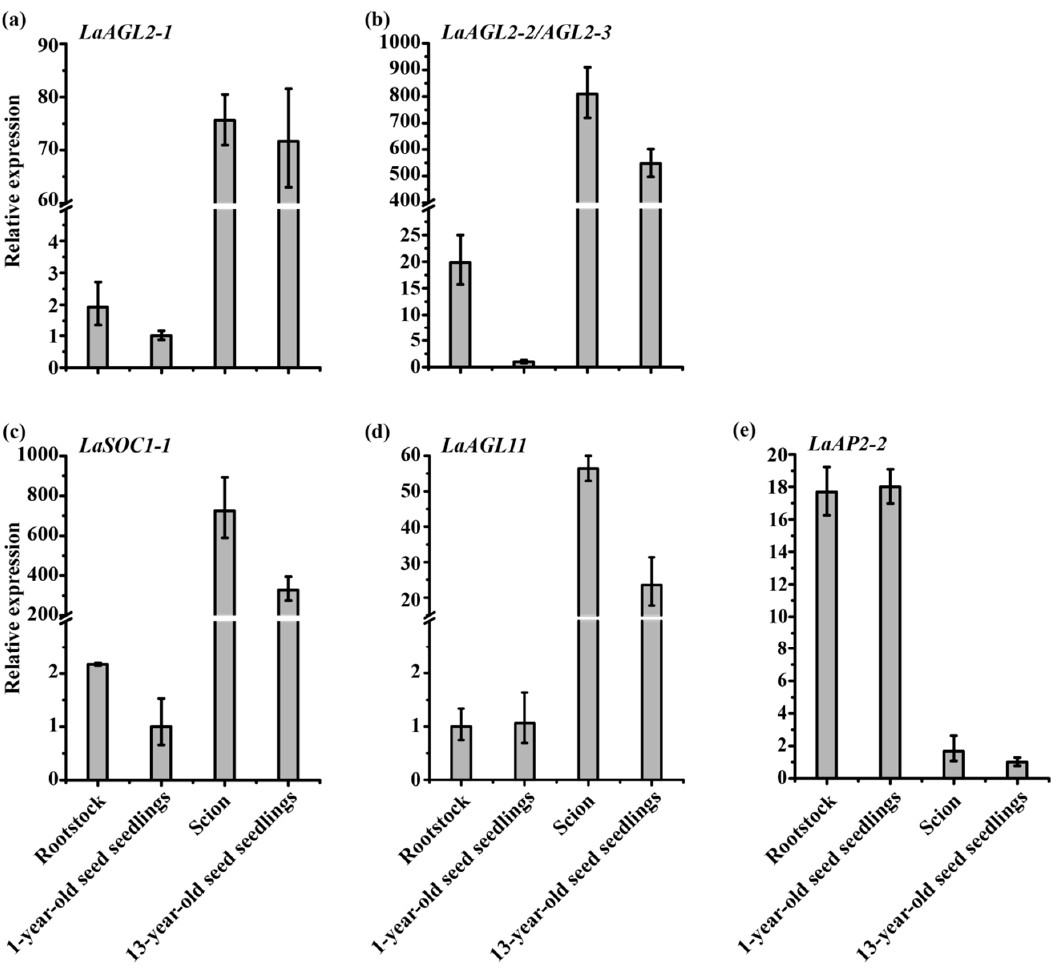
Figure 7. Expression patterns of LaAGL2-1 ( a ), LaAGL2-2 ( b ), LaAGL2-3 ( b ), LaSOC1-1 ( c ), LaAGL11 ( d ), and LaAP2-2 ( e ) in 3-month-old grafted seedlings ( n = 6, sampled in 2019) and 1- and 13-year-old seed seedlings ( n = 11, sampled in 2019) assayed by qRT-PCR with LaFBP1 as the internal control.